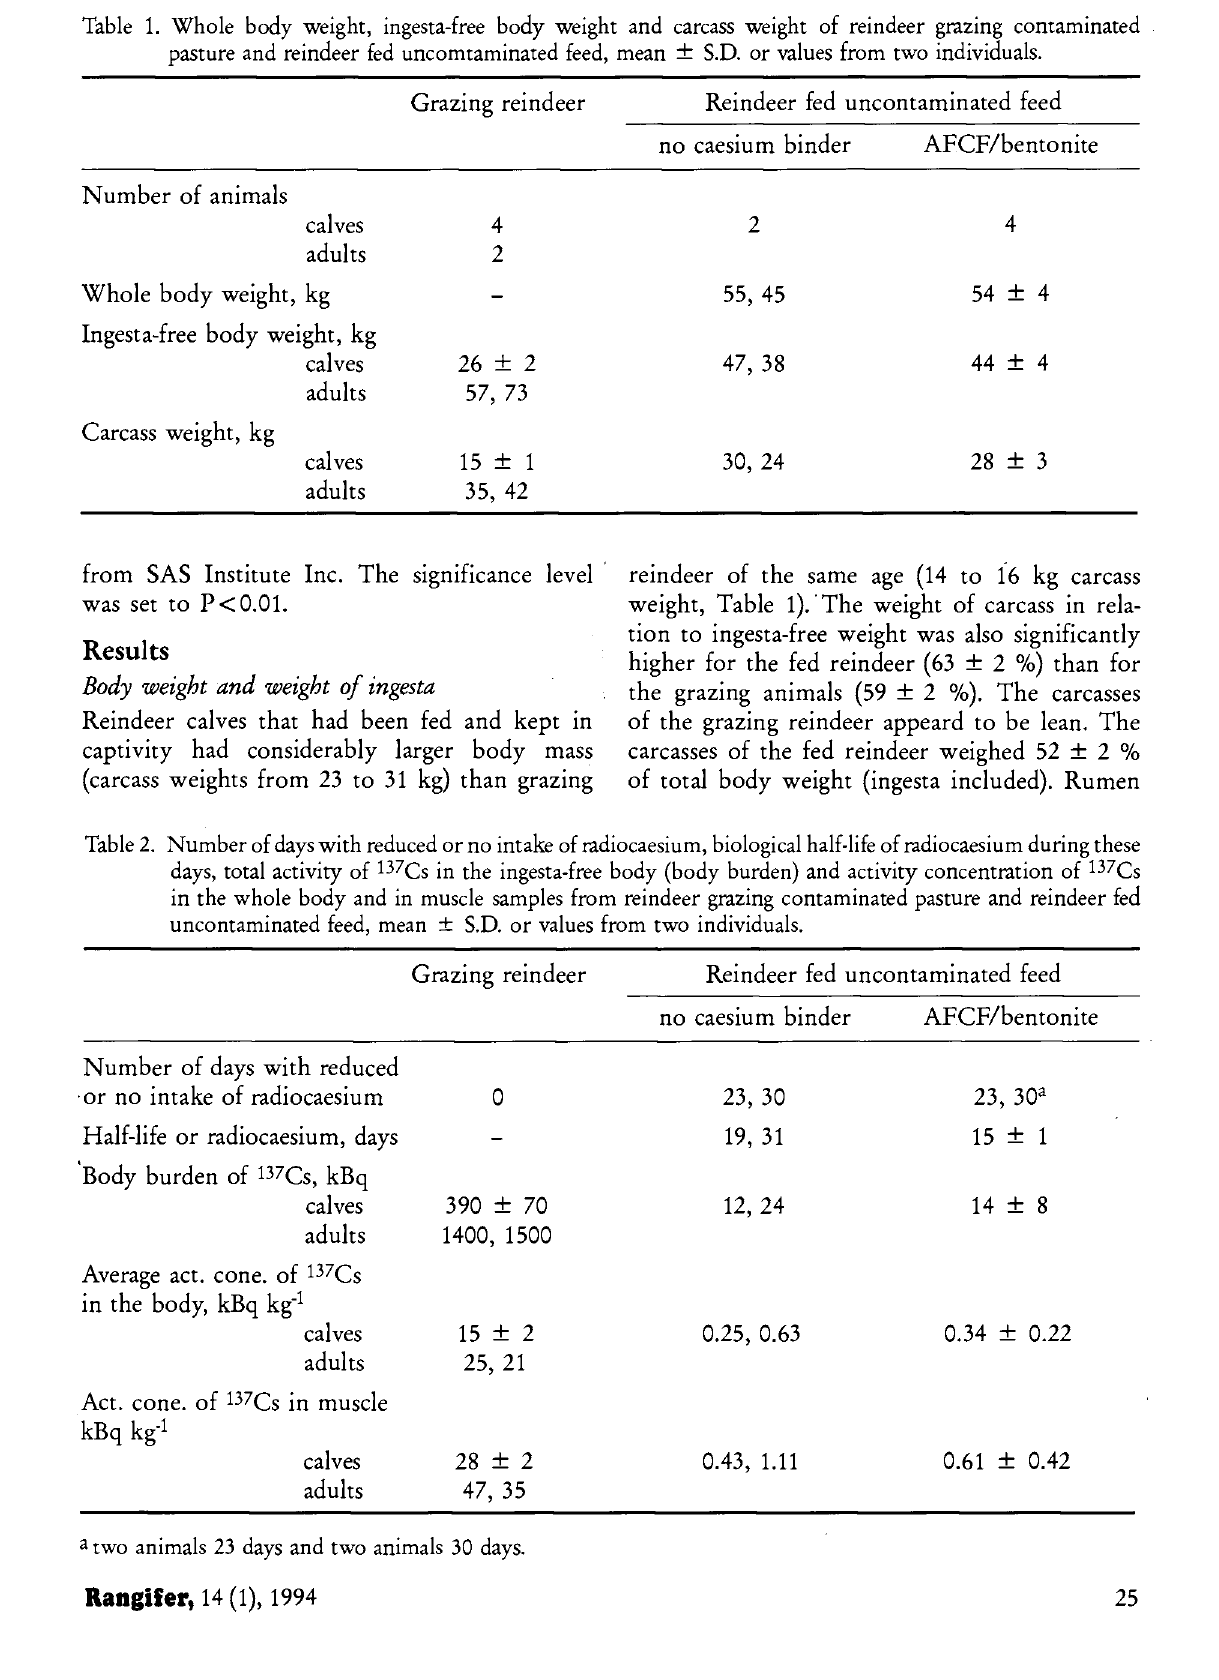
Table 1. Whole body weight, ingesta-free body weight and carcass weight of reindeer grazing contaminated pasture and reindeer fed uncomtaminated feed, mean ± S.D. or values from two individuals.